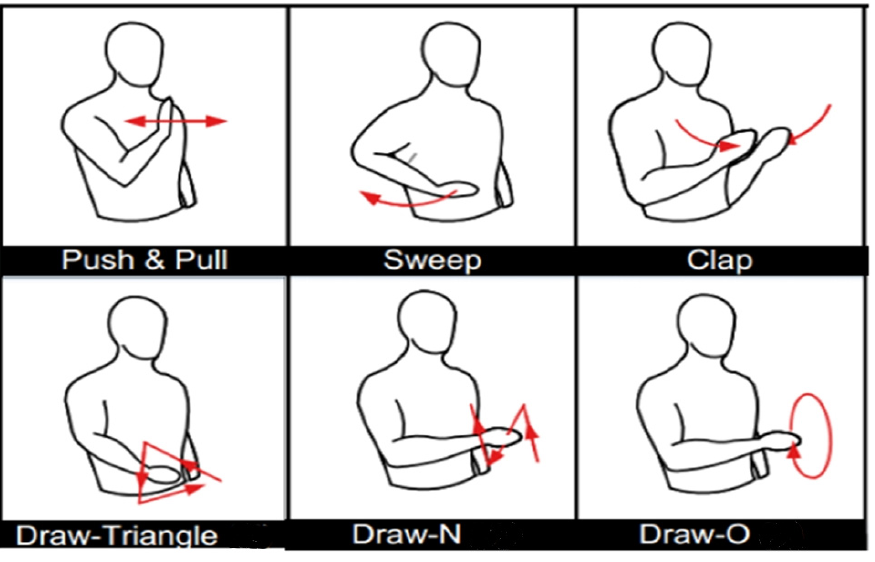
Figure 10. Types of gestures used for experiments.